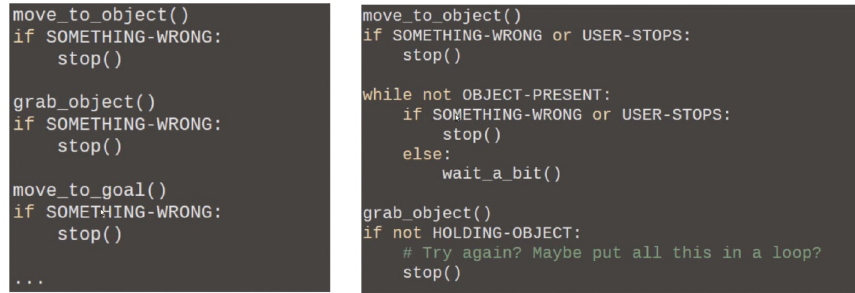
Figure 3: Example of a procedural policy: basic code (left), extended with sensor input